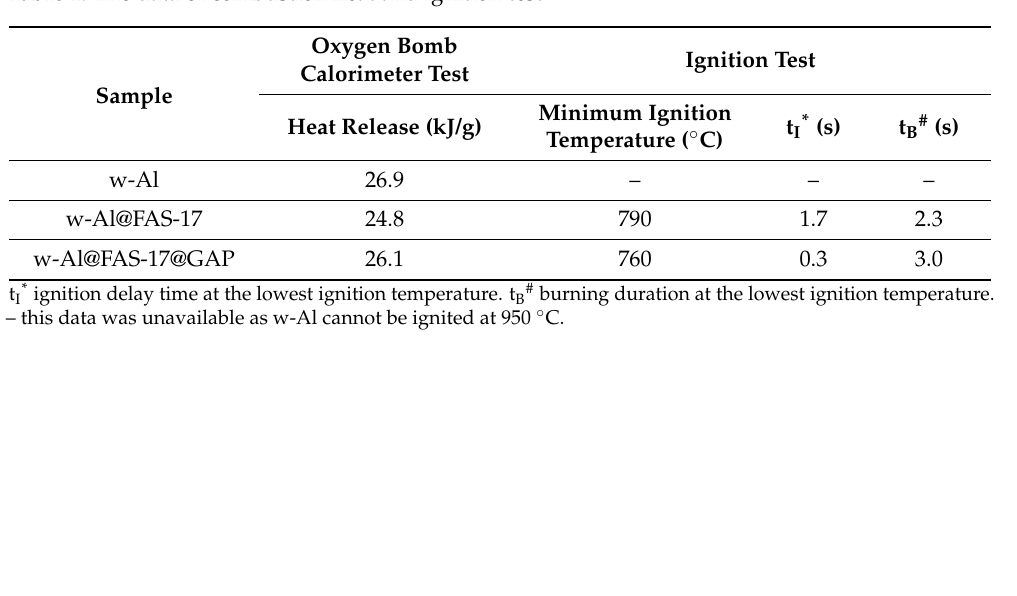
Table 1. The data of combustion heat and ignition